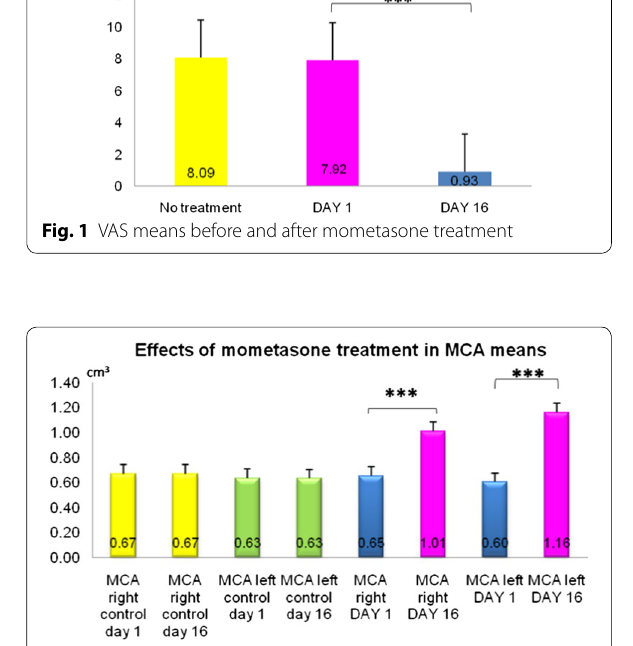
Fig. 2 Effects of mometasone treatment in MCA